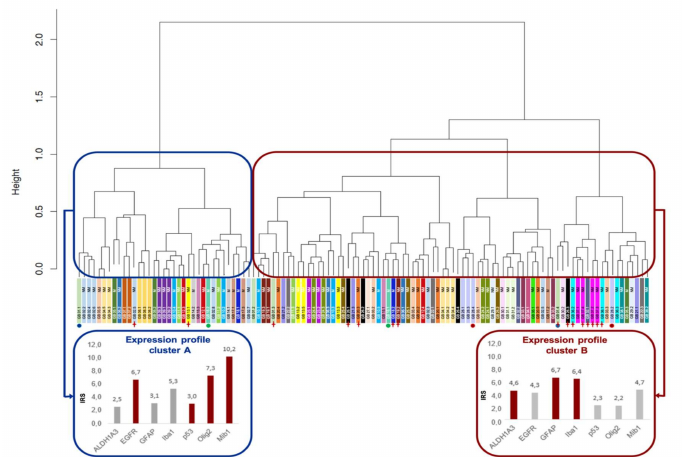
Figure 2. Hierarchical clustering divides the tumor areas into two subtypes. The blue frame is used for cluster A , which is comparable to the classical subtype by Verhaak et al. [2], the red frame marks cluster B with characteristics of the mesenchymal subtype. In the lower section of the figure, the characteristic immunohistochemical profiles of both clusters are pictured as bar charts. Red bars are used for markers that exceed the average immune reactive score (IRS). The stripes directly below the hierarchical tree with the same color represent the di ff erent AoI of the same tumor. In these stripes, information about O-6-methylguanin-DNA methyltransferase (MGMT) promotor status can be found (M = methylated, NM = non-methylated). The dots under the di ff erent colored AoIs samples, which consist of pairs of three colors, mark the AoIs that were analyzed epigenetically (the same colors were used in Figure 5b). The red crosses mark the AoIs, whose cluster assignment di ff ers in partitioning around medoids